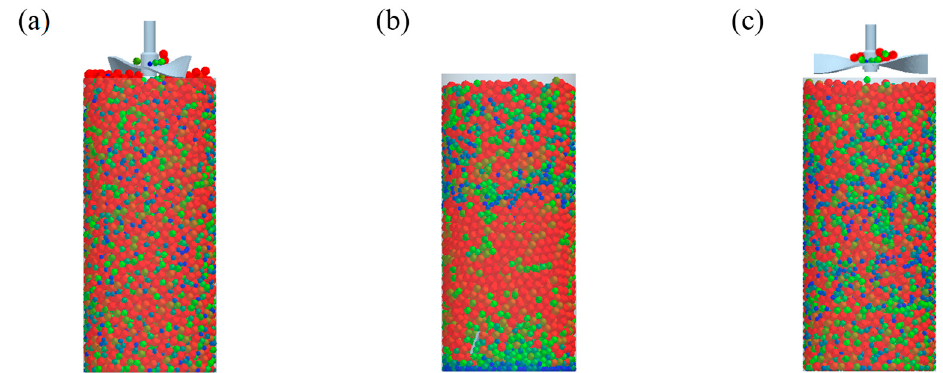
Figure 6. State of particle arrangement for size distribution in the basic flow energy (BFE) test simulation: ( a ) initial state, ( b ) state after the completion of test cycle, and ( c ) state after the completion of conditioning cycle. The green, blue, and red particles are D 10 , D 50 , and D 90 , respectively.